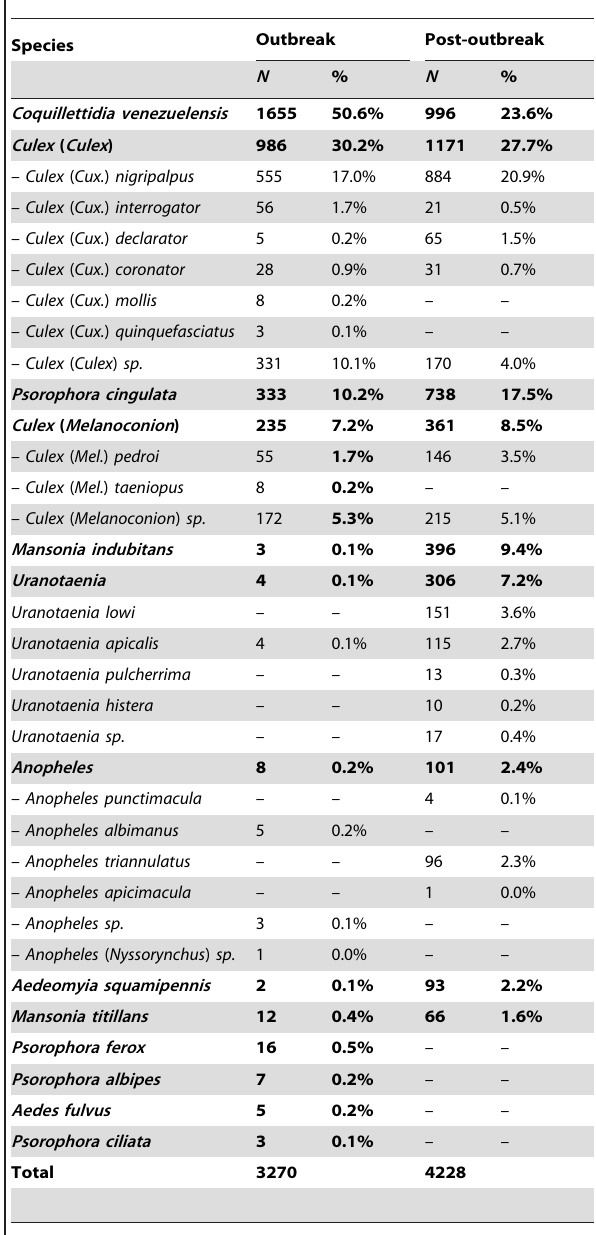
pairs, 38 (82.6%) recovered the same vertebrate host, while five samples (10.9%) recovered one vertebrate host on the forward sequence and another vertebrate host with the reverse primer generated from the same COI amplification. Only three samples (6.5%) recovered one host with one primer pair and a different